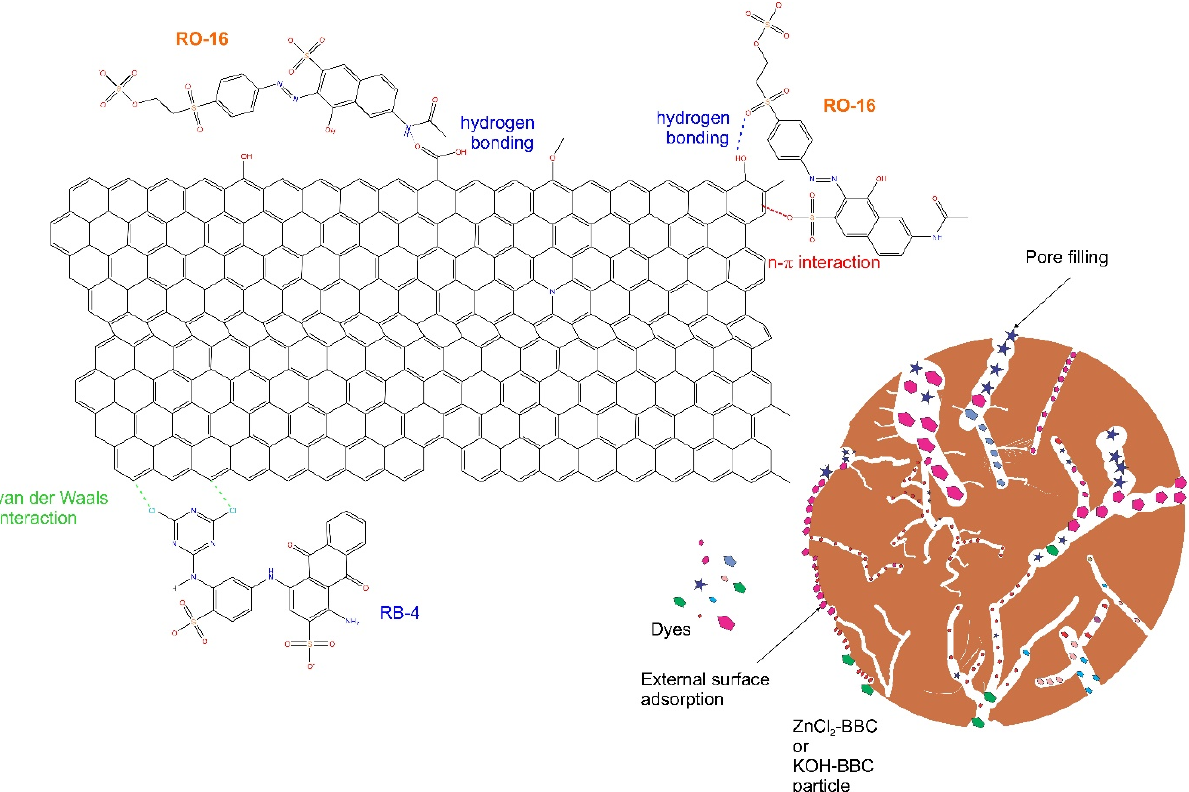
Figure 9. Schematic mechanism of adsorption of RO-16 and RB-4 onto BBC structure.